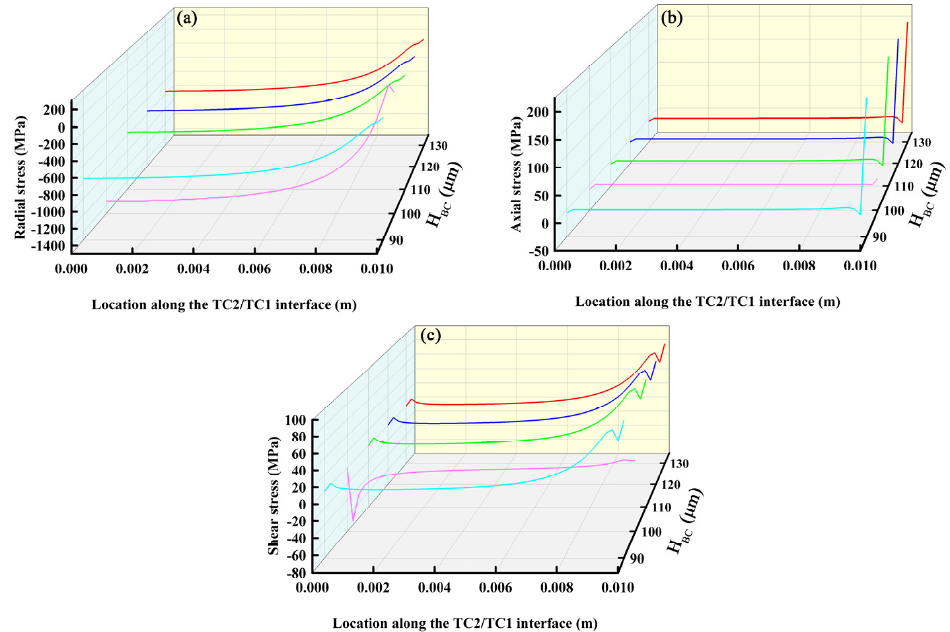
Figure 9. Stress distributions along TC2/TC1 interface: ( a ) radial stress; ( b ) axial stress and ( c ) shear stress.